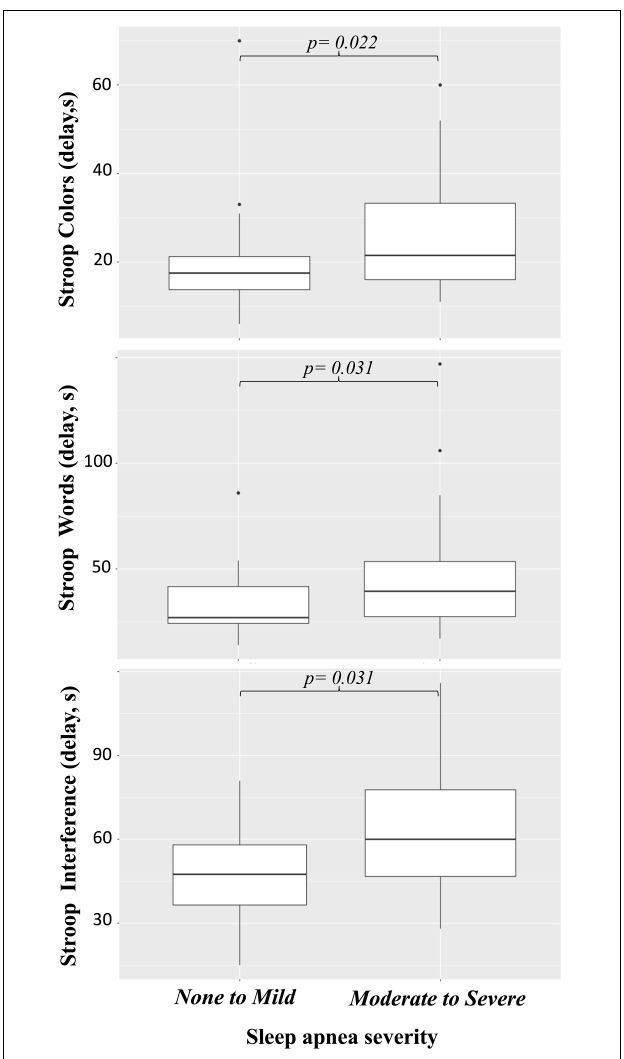
FIGURE 3 | Effects of sleep apnea on Stroop